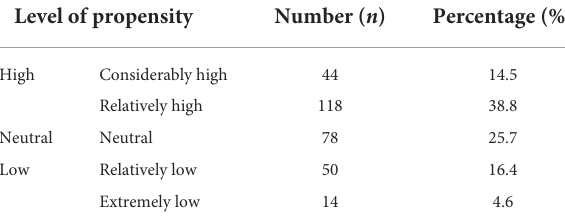
TABLE 4 Physicians’ evaluations of doctor–patient relationship. Perceived relationship